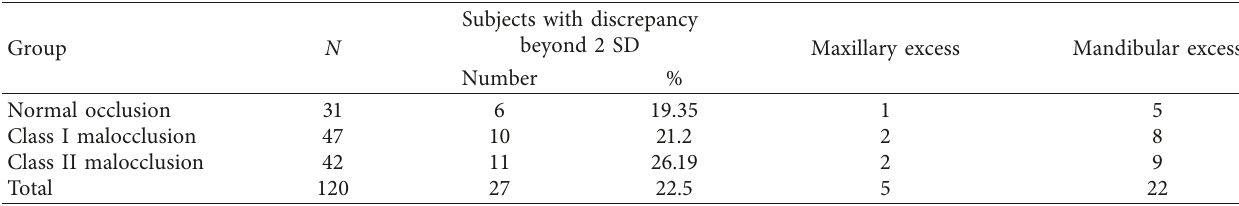
Table 7: Frequency of distribution of subjects with anterior ratio beyond mean ± 2 SD of Bolton’s norms (77.2 ± 1.65). Group N